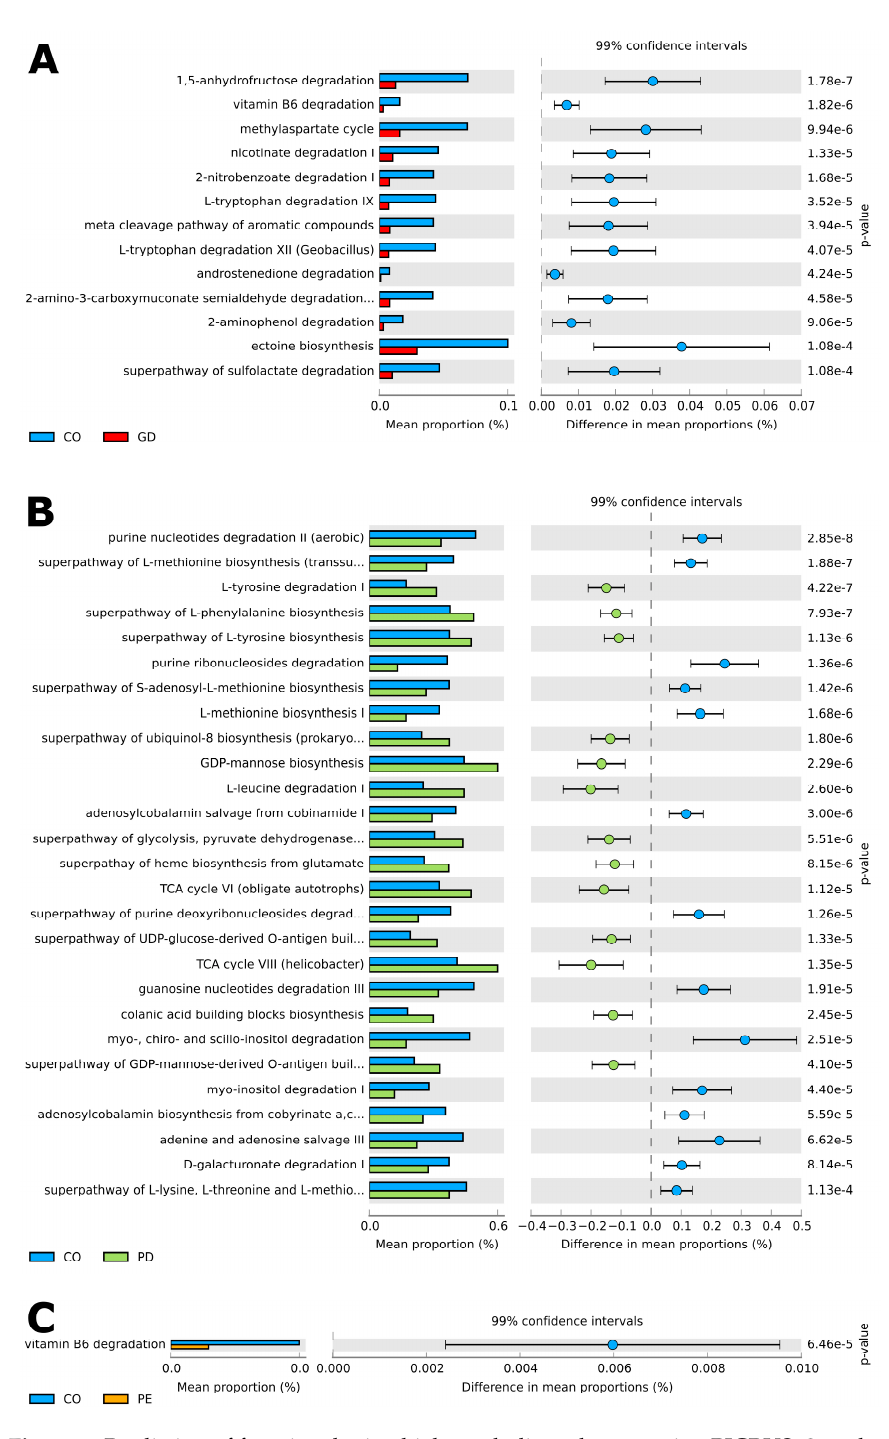
5 Figure 5. Prediction of functional microbial metabolic pathways using PICRUSt 2 analysis with the MetaCyc database. The graphics show the abundance of ( A ) thirteen statistically significant